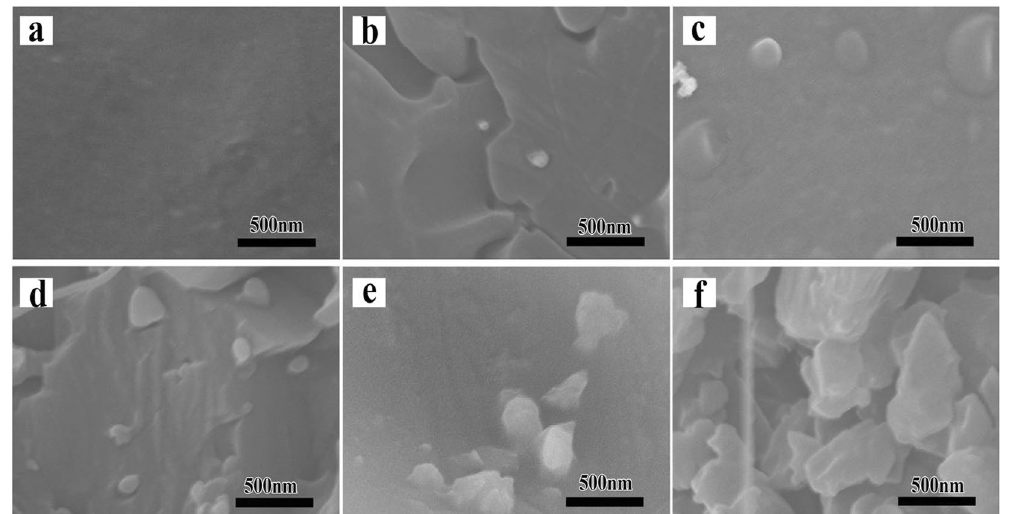
Figure 3. Cross-sectional SEM micrographs of cryogenically fractured melt-processed PPS/C 60 with different weight fractions of C 60 ( a ) PPS; ( b ) 0.5 wt%; ( c ) 1 wt%; ( d ) 2 wt%; ( e ) 5 wt%; ( f ) 10